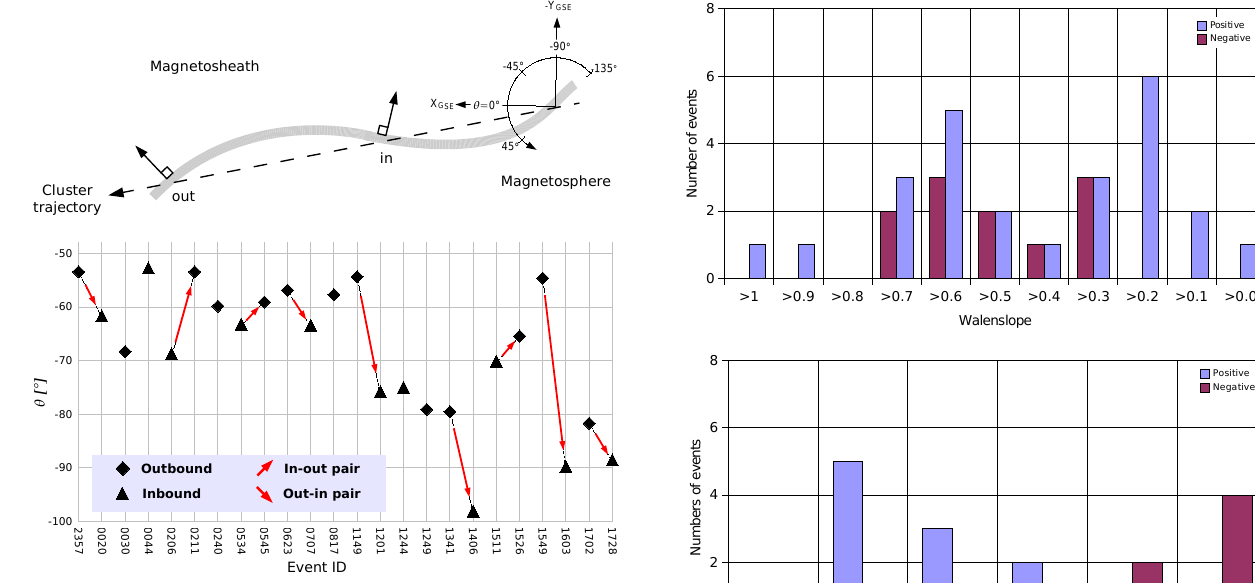
Fig. 12. Top: Illustration of surface waves on the dawn flank mag- netopause and definition of azimuth angle. The boundary normals of the inbound and outbound crossings should have different az- imuthal angles. Bottom: azimuth angle, θ , of the boundary normal for the 24 crossings, ordered chronologically from left to right along the abcissa. For most of the cases, there is a systematic difference in the normal direction for inbound (triangles) and outbound (dia- monds) crossings. The red arrows indicate crossing pairs with an orientation change as expected from surface waves.